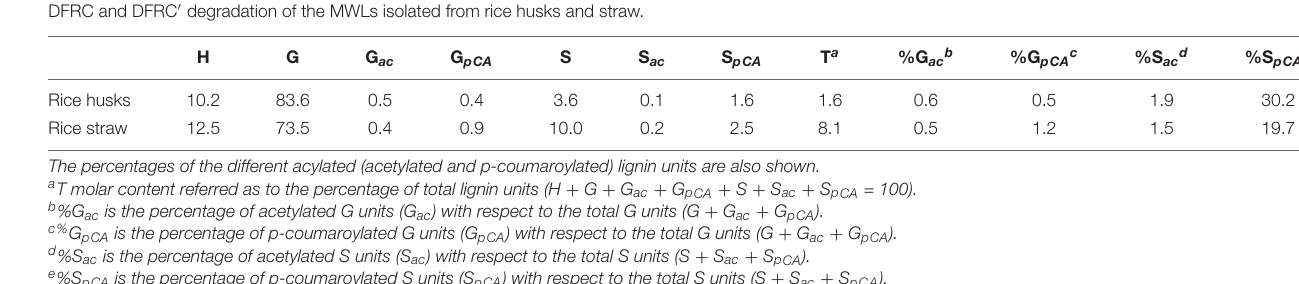
TABLE 5 | Relative molar abundance of the normal γ -OH (H, G, S), γ -acetylated (G ac , S ac ), and γ - p -coumaroylated (G pCA , S pcA ) lignin units, and tricin (T), obtained from DFRC and DFRC (cid:48) degradation of the MWLs isolated from rice husks and straw. H